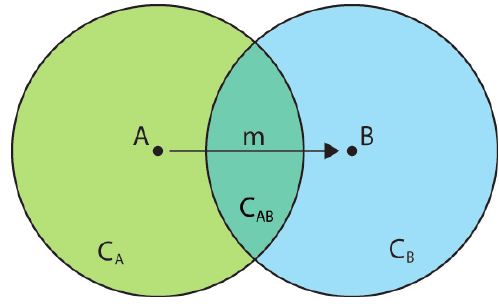
Figure 2. Context-aware Communication schema considering sender ( A ), receiver ( B ), message ( m ), and the overlapping contexts of A and B .